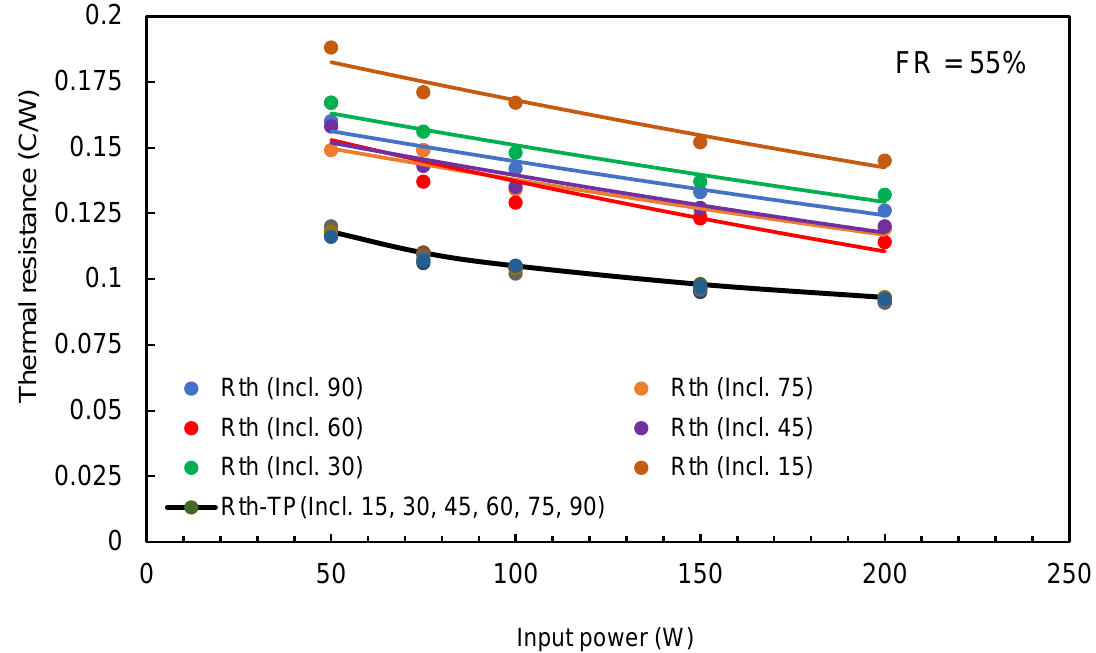
Figure 19. Variation of thermal resistance with input power for different inclination angles with and without TP (FR = 55%).